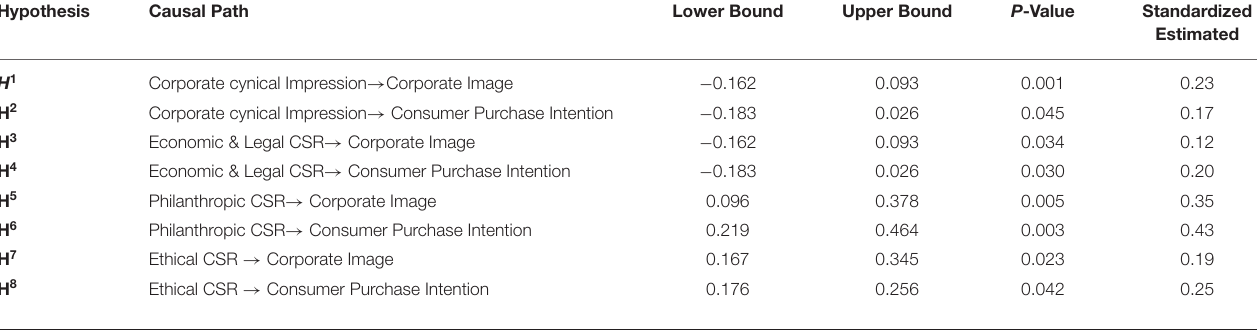
TABLE 7 | Results of direct effects.